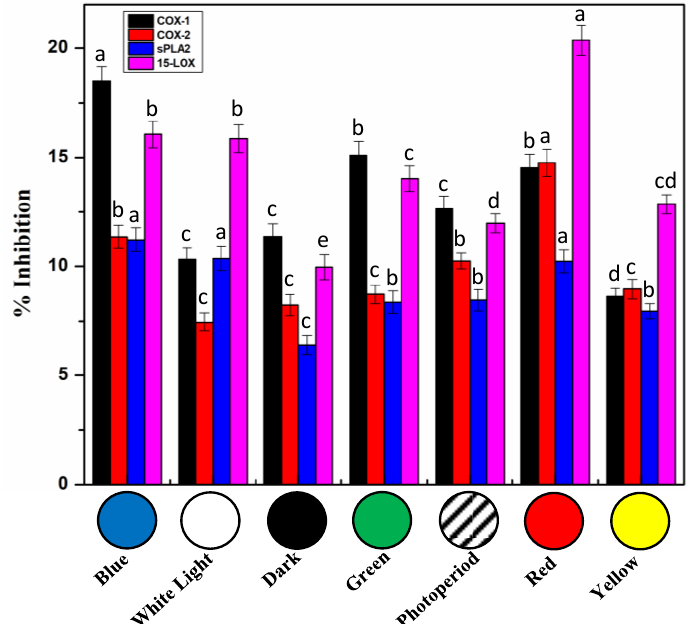
Figure 10. In vitro cell-free anti-inflammatory activity of extracts from callus cultures of S. xanthocarpum grown under di ff erent monochromatic lights conditions after 35 days of cultivation. Employed under the same experimental conditions, reference inhibitors were used as positive controls; Ibuprofen (10 µ M) was used as positive control for COX-1 and COX-2 activity leading to enzyme inhibition of 31.4 ± 0.8% and 29.8 ± 1.2%, respectively; thioetheramide-PC (5 µ M) was used as sPLA2 inhibitor, resulting in an inhibition of 43.7 ± 0.8%; nordihydroguaiaretic acid (100 µ M) was used as 15-LOX inhibitor, leading to an inhibition of 30.6 ± 0.7%. The same volume of extraction solvent was used as blank. Data are expressed in terms of mean ± SD of at least three independent experiments. Di ff erent letters indicate significant di ff erences between conditions ( p <